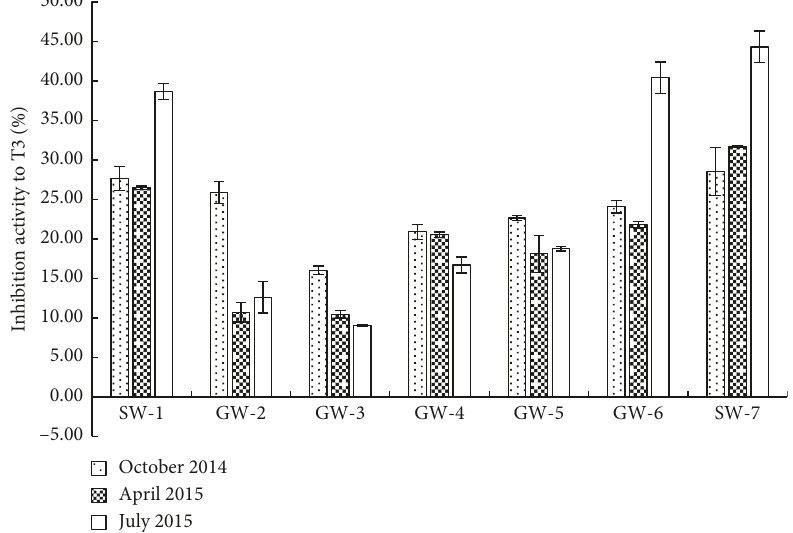
Figure 3: Inhibition of β -galactosidase activity by water samples using recombinant TR gene yeast